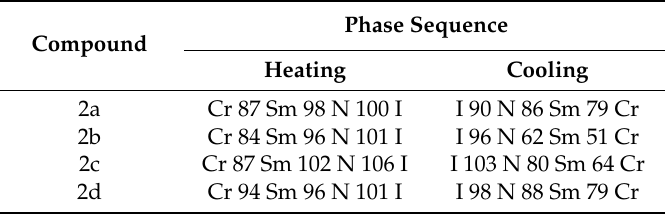
Table 1. Phase transition temperatures ( ◦ C) of compounds 2a–d.